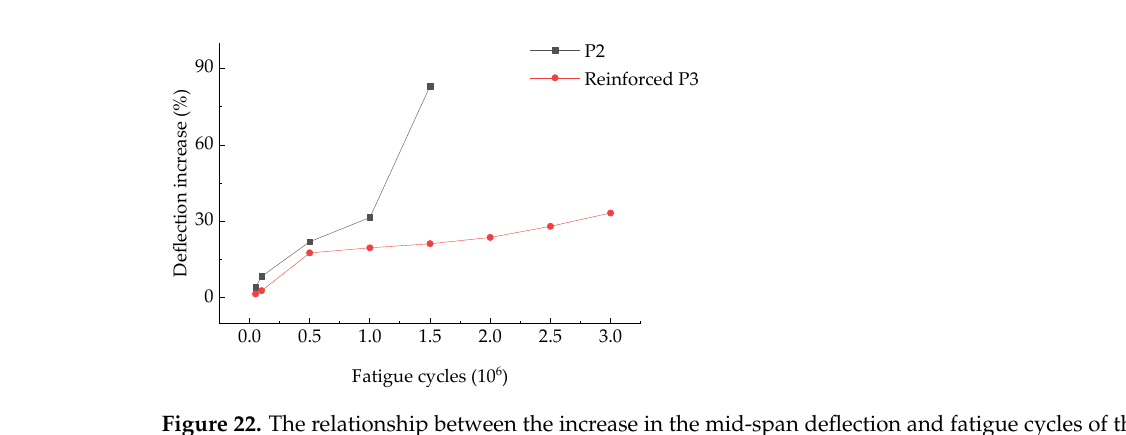
Figure 22. The relationship between the increase in the mid-span deflection and fatigue cycles of the P2 and reinforced P3.